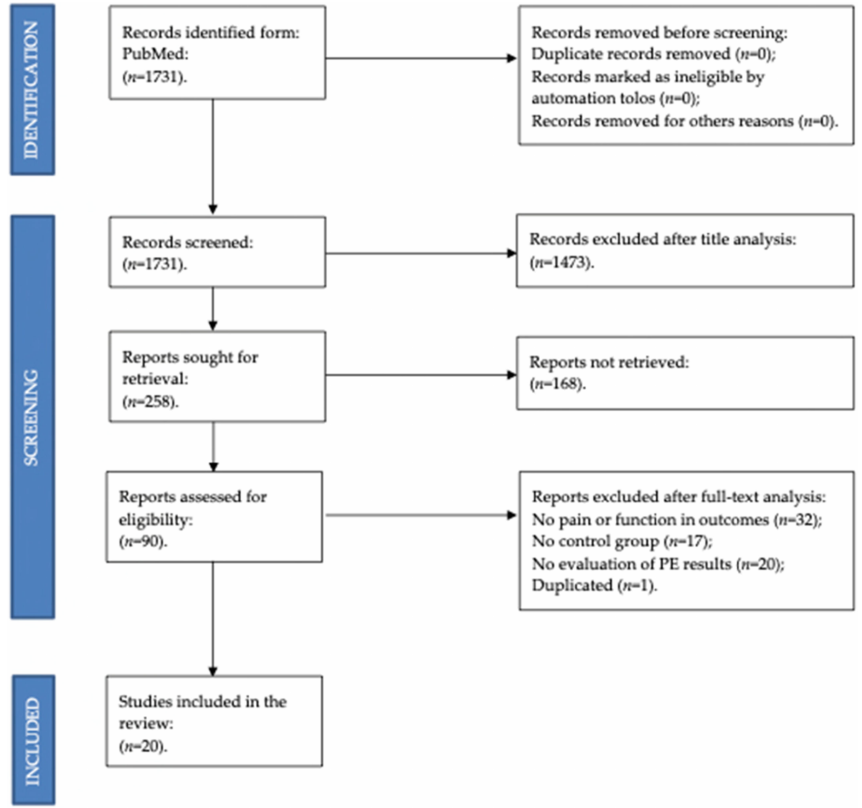
Figure 1. PRISMA flow